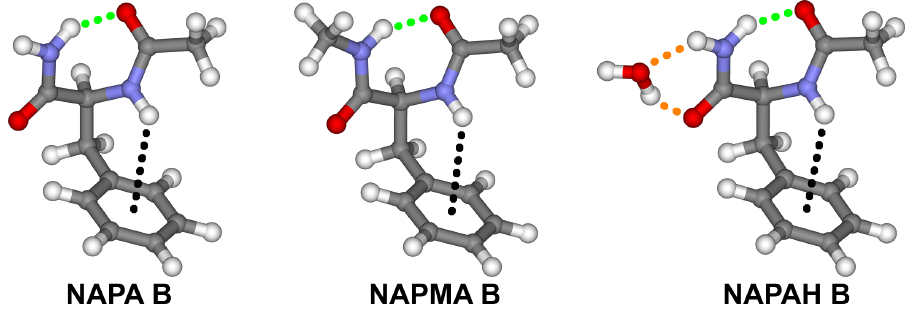
Figure 1. Chemical structure of the three systems under investigation: N -acetylphenylalanylamide (NAPA, left ); N -acetylphenylalanylmethylamide (NAPMA, middle ) and N -acetylphenylalanylamide monohydrate (NAPAH, right ) conformers B ( γ L ( g +) ). Dots denote hydrogen bonding